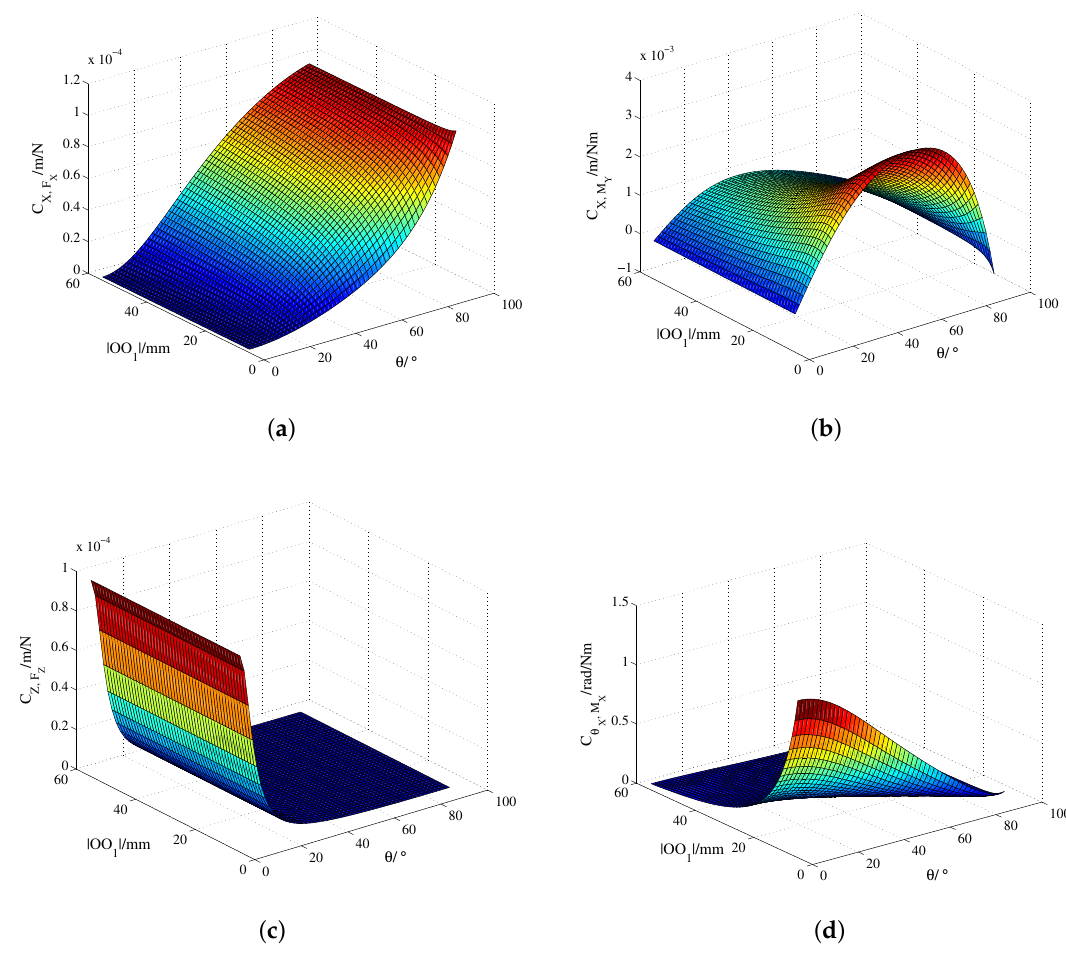
Figure 9. Compliance factors plots in terms of mechanism geometry. ( a ) Compliance C X , F ( b ) Compliance C X , M